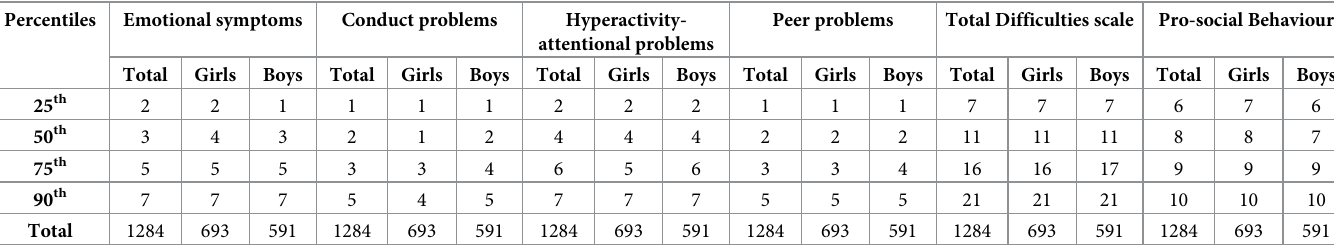
Table 5. Normative data for total scores by sex based on adolescent self-report.